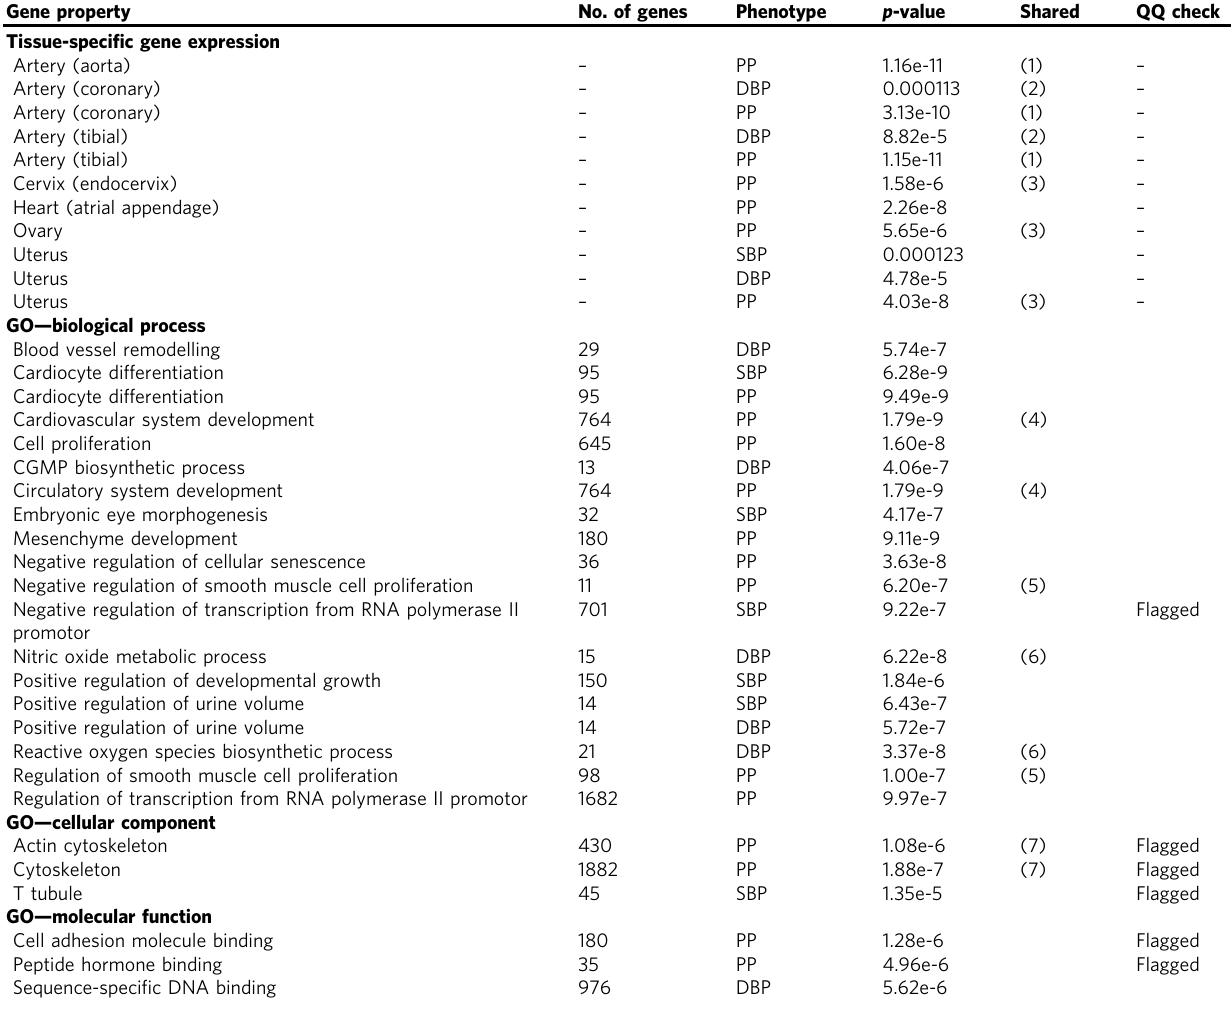
p -Values are from step 2 of the analysis work fl ow, after correcting for general confounders. Gene properties that likely re fl ect a single shared association are marked by the same number in the ‘ Shared ’ column. Gene sets for which issues were noted during inspection of the QQ-plots are marked in the ‘ QQ check ’ column. These are still valid, but require more caution when interpreting their association SBP systolic blood pressure, DBP diastolic blood pressure, PP pulse pressure, GO Gene